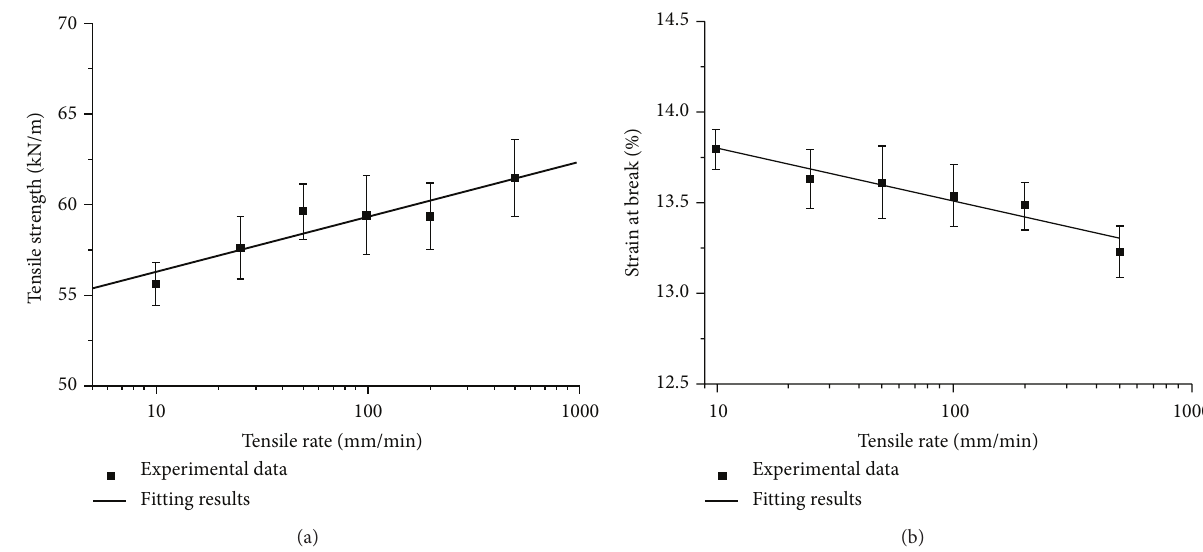
Figure 8: Relationship between tensile strength and strain at break and tensile rate.